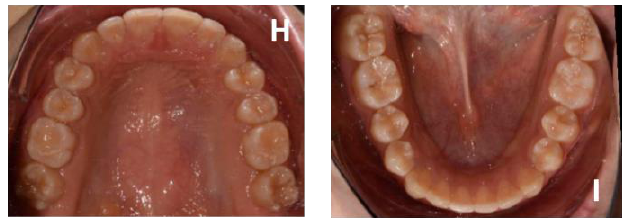
Figure 18. Post-treatment intraoral and extraoral photos of case number 2: frontal facial view ( A ); frontal facial view smiling ( B ); right facial view ( C ); right facial view smiling ( D ); right arches view ( E ); frontal arches view ( F ); left arches view ( G ); upper arch occlusal view ( H ); lower arch occlusal view ( I ).